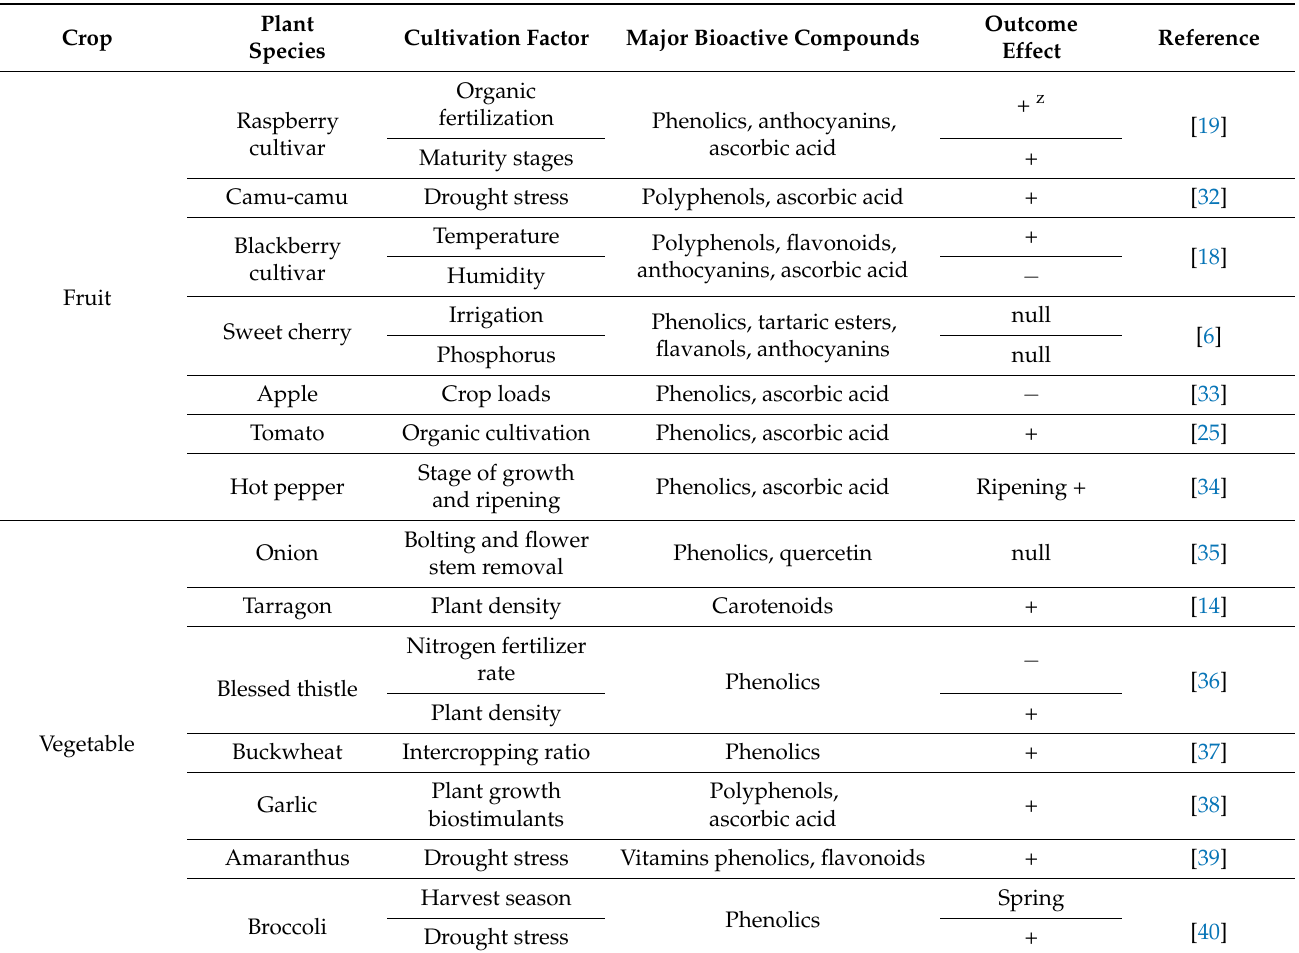
Table 1. Research studies to improve bioactive compound levels in plant foods in ground-based uncontrolled urban